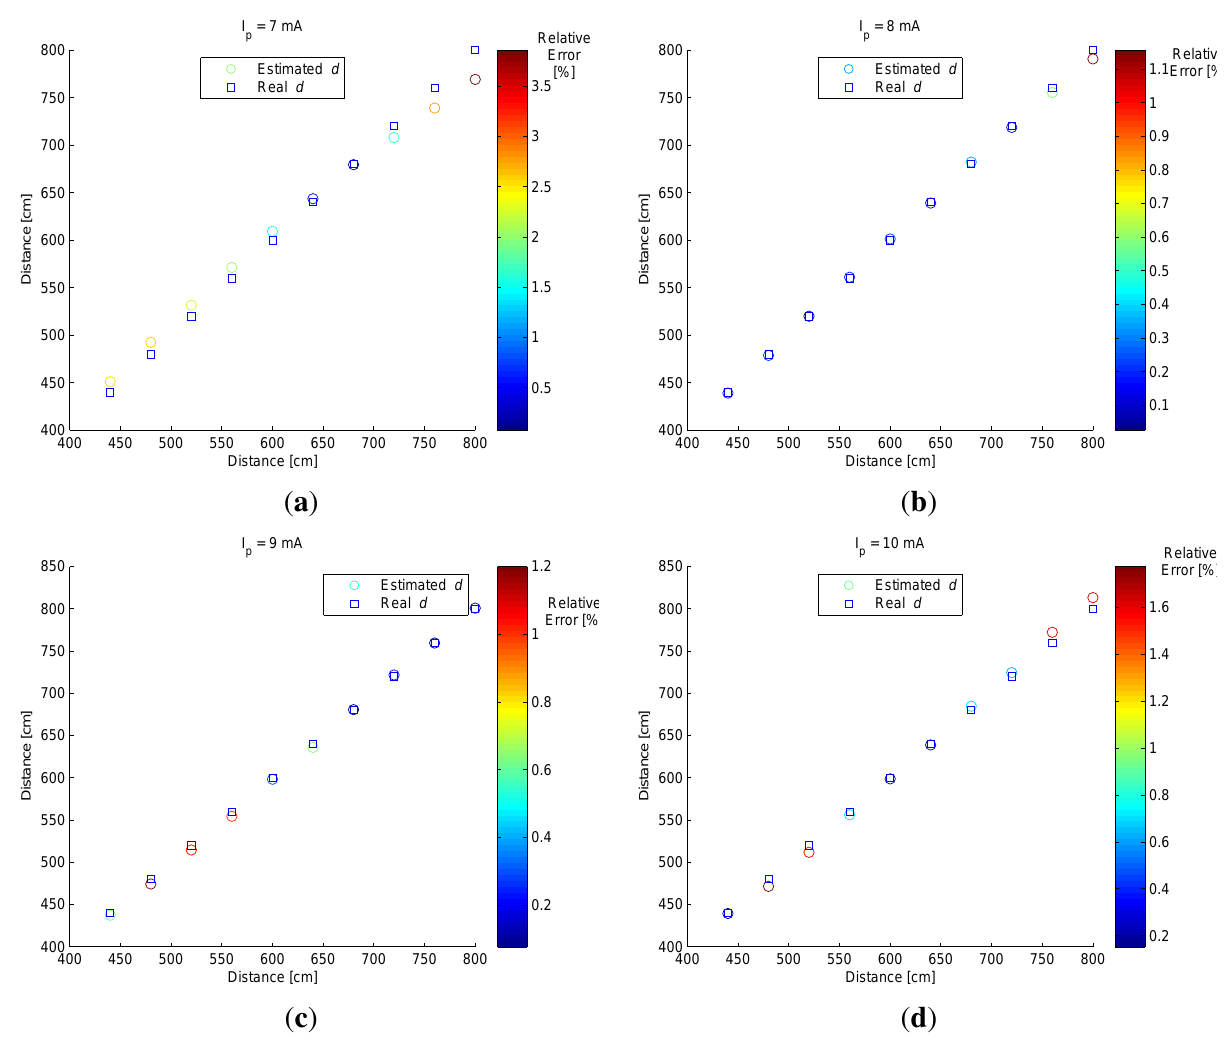
Figure 12. Results of distance estimation process considering the optimum difference of exposure times ( △ t = 13 ms) for each of the bias currents used; (a) for I I = 8 mA, (c) for I = 9 mA and (d) for 10 mA. The final results are also summarized p p